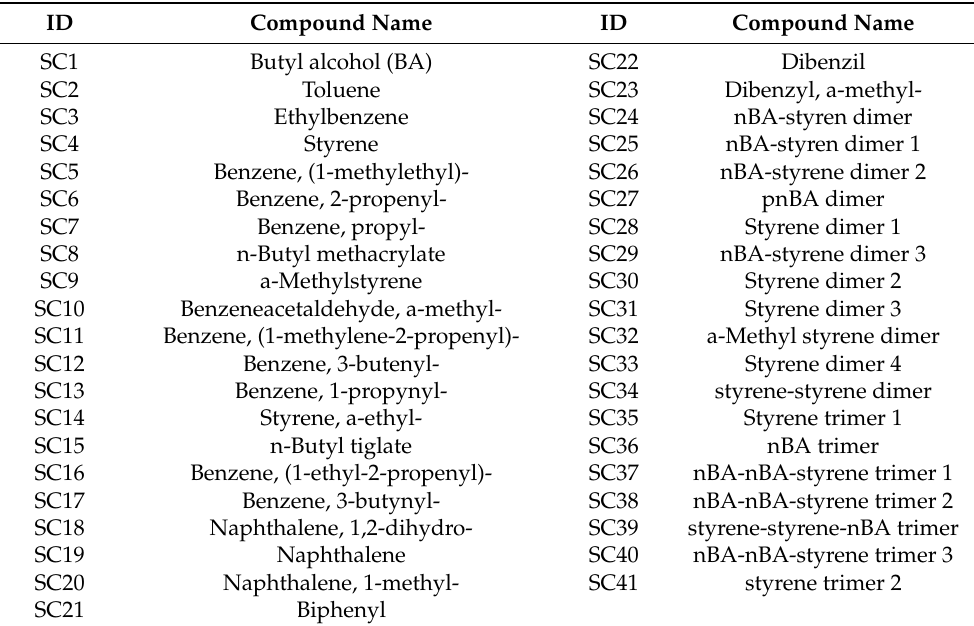
Table A1. List of all compounds identified in styrene-acrylic samples unaged and aged using Py- GC/MS and corresponding abbreviation used in data fusion evaluation.